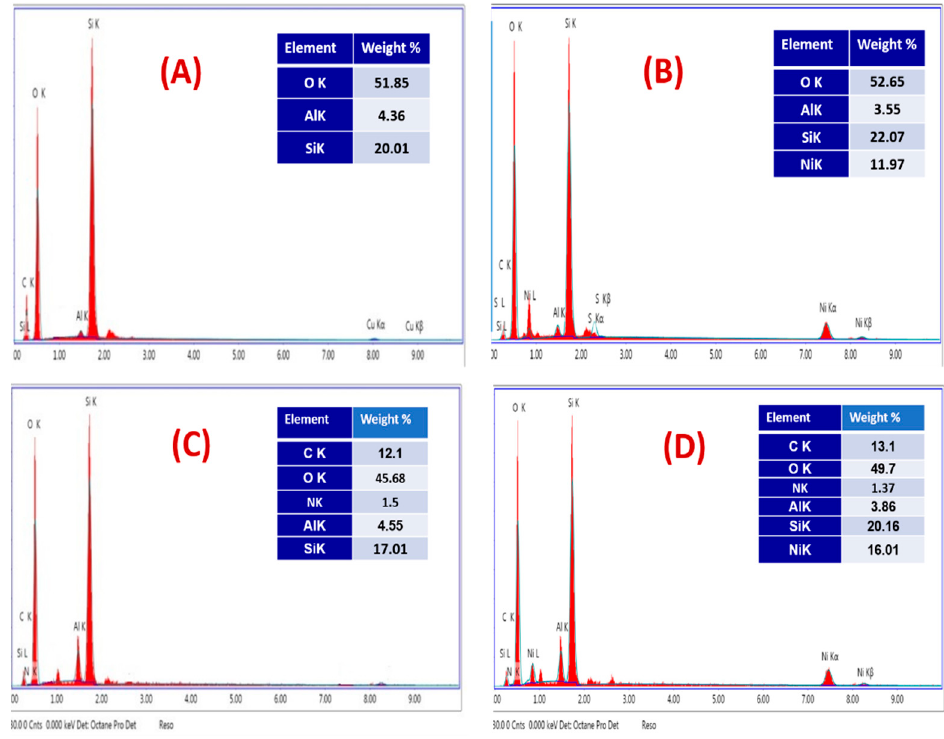
Figure 4. EDX of ( A ) SCB, ( B ) Ni-sorbed SCB, ( C ) SBDP, ( D ) Ni-sorbed SBDP nanocomposite.